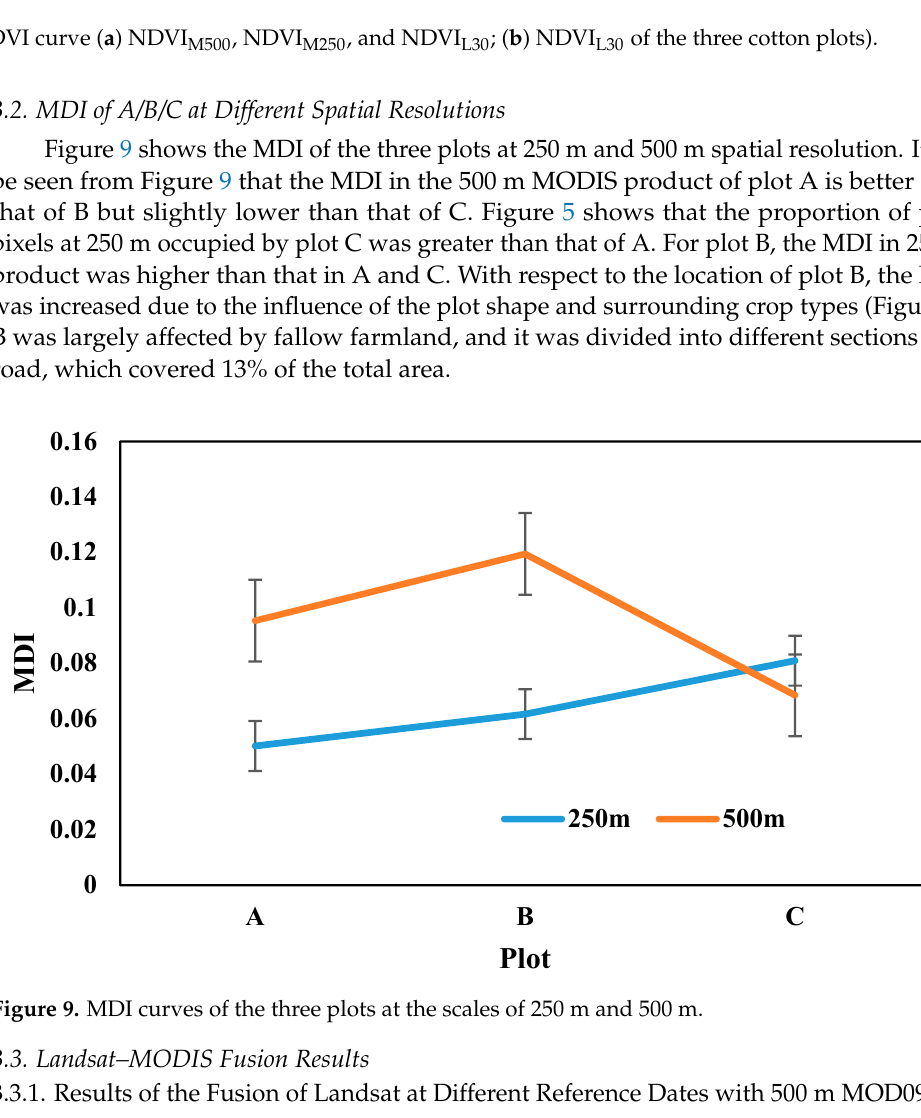
Figure 9. MDI curves of the three plots at the scales of 250 m and 500 m.